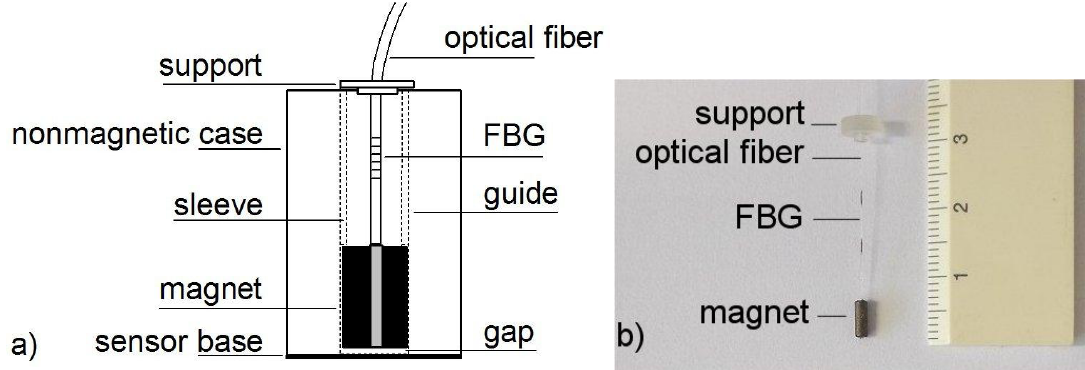
Figure 2. ( a ) Schematic drawing of the FBG magnetic force sensor; ( b ) Photograph of the sensor inside the nonmagnetic case, containing a 2.0 mm diameter magnet, 5.0 mm long and the optical fiber. The Bragg grating was inscribed approximately in the middle of the 2 dark marks on the optical fiber. The scale is in